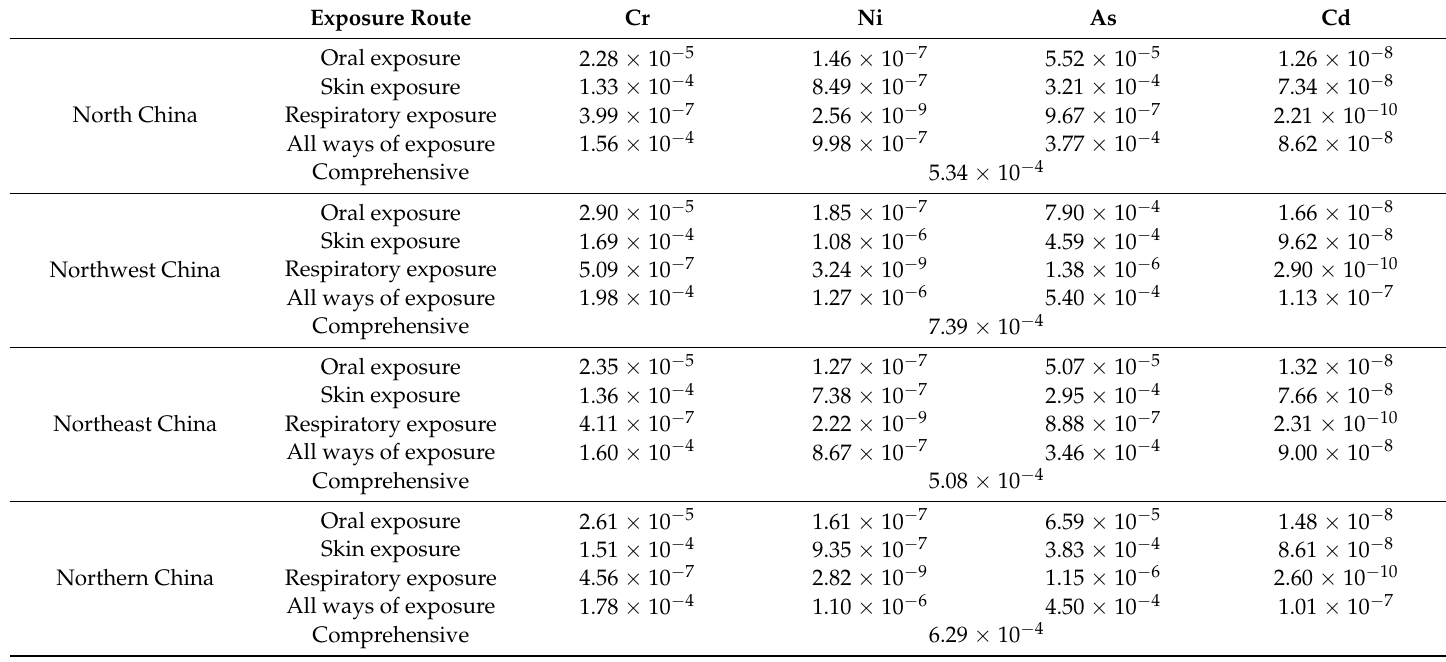
Table 9. Carcinogenic risk indices and risk rating in the study area.